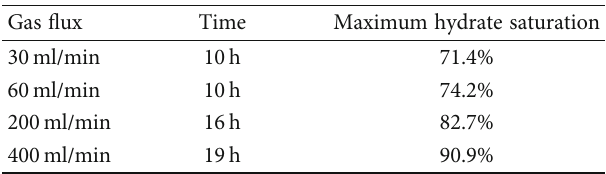
Figure 5: Extracted gas distribution during hydrate formation process under methane fl ux conditions. (a) Gas ratio=5.35%, (b) Gas ratio=11.65%, (c) Gas ratio=11.99%, (d) Gas ratio=11.35%. Di ff erent colors represent the size of the gas Table 2: E ff ect of methane fl ux on hydrate formation rate and hydrate saturation.